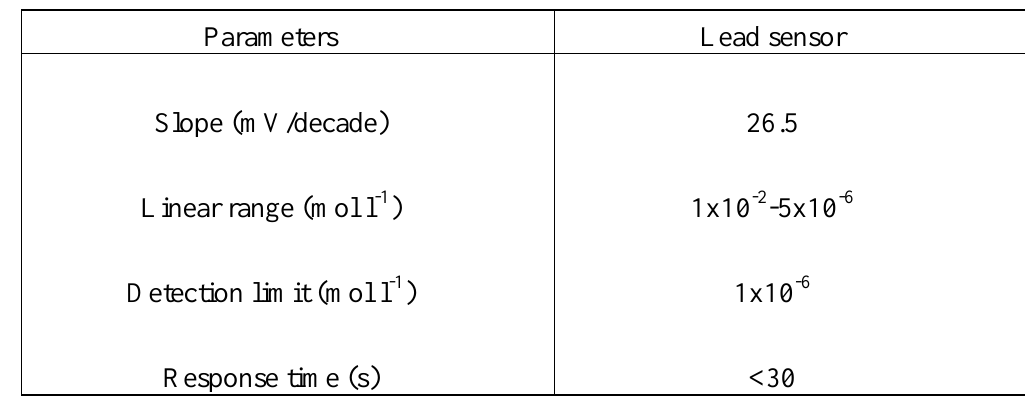
Table 3. Characteristics of thin-film lead